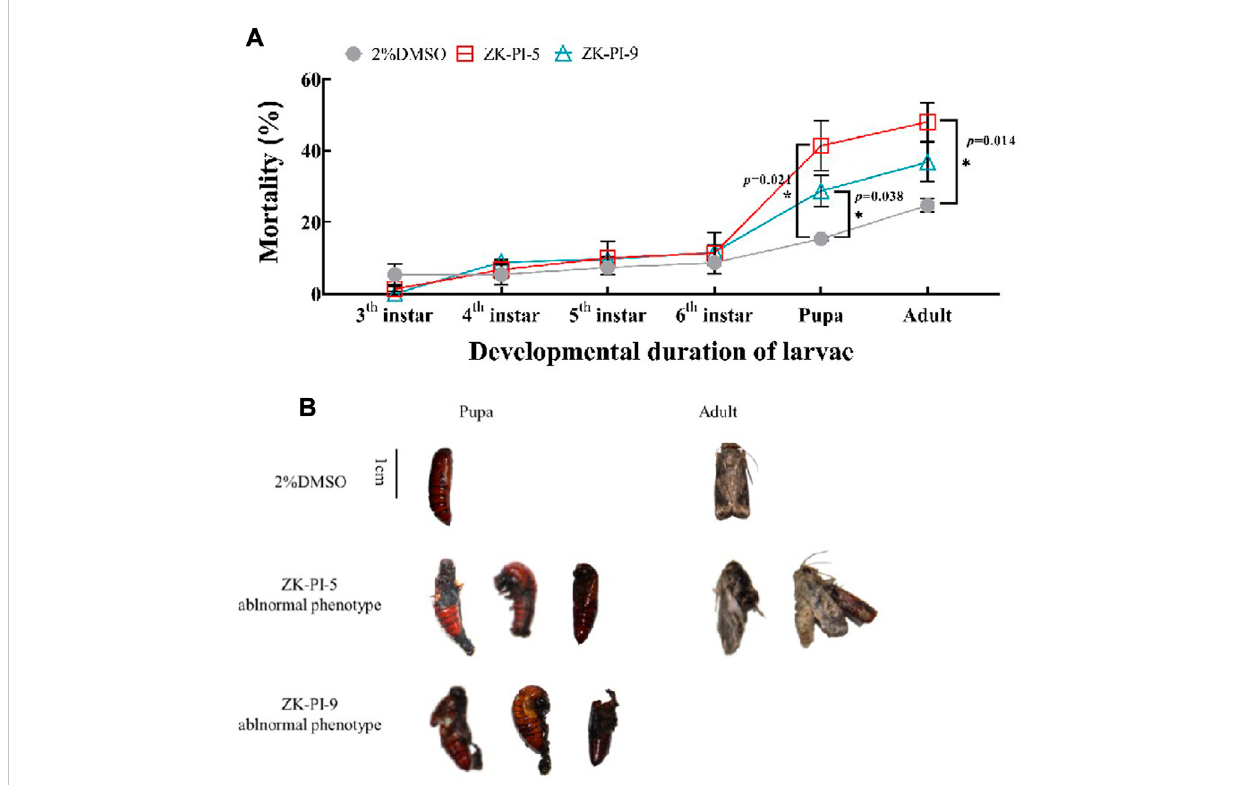
FIGURE 7 Death rates (A) and phenotype (B) of S. frugiderda after injection of two trehalase inhibitors. The number of deaths of S. frugiderda during development after injection of trehalase inhibitors were counted, and all death phenotypes were recorded. Values are presented as the means ± SE. * p < 0.05 denotes signi fi cant differences. ** p < 0.01 denotes extremely signi fi cant differences (independent-samples t